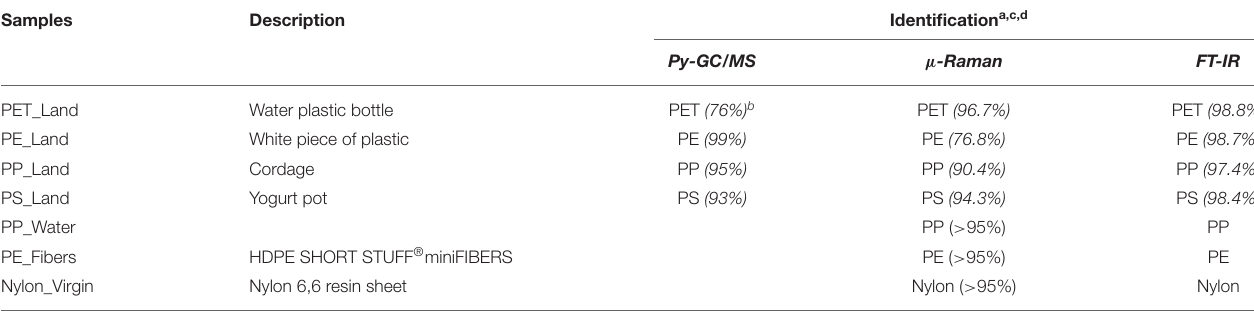
TABLE 1 | Result of identification for the selected items, before transformation to microplastics. Samples